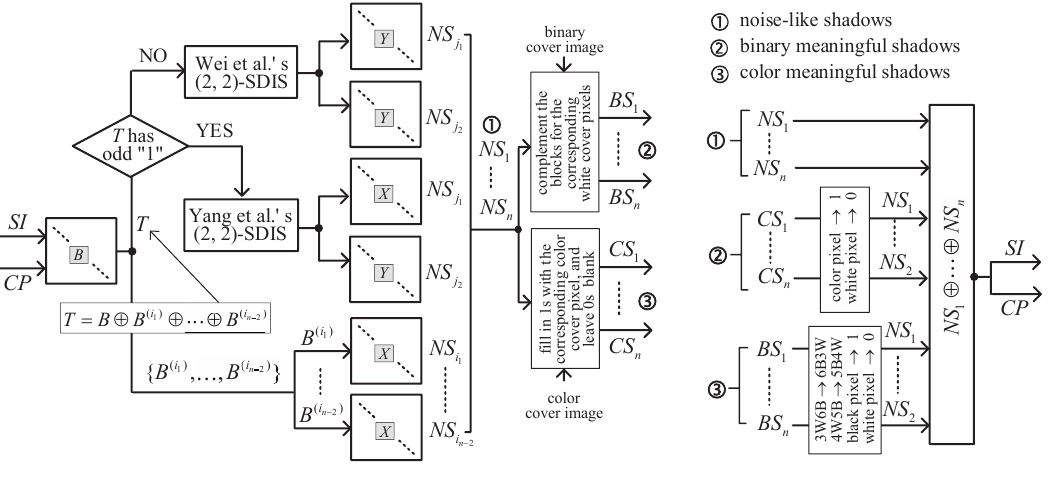
Figure 3. Block diagram of the proposed ( n , n )